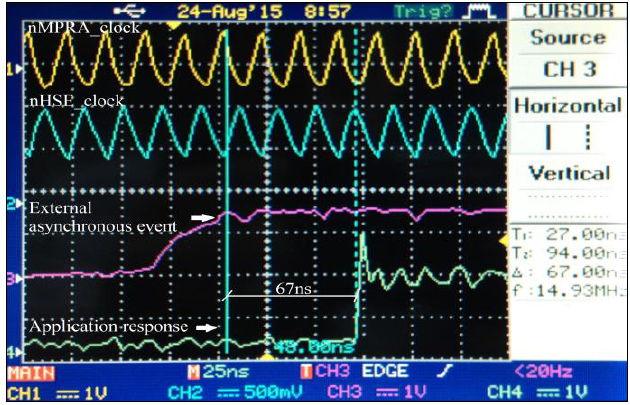
Fig. 8. Application response in relation with an external asynchronous event when the program executes sw